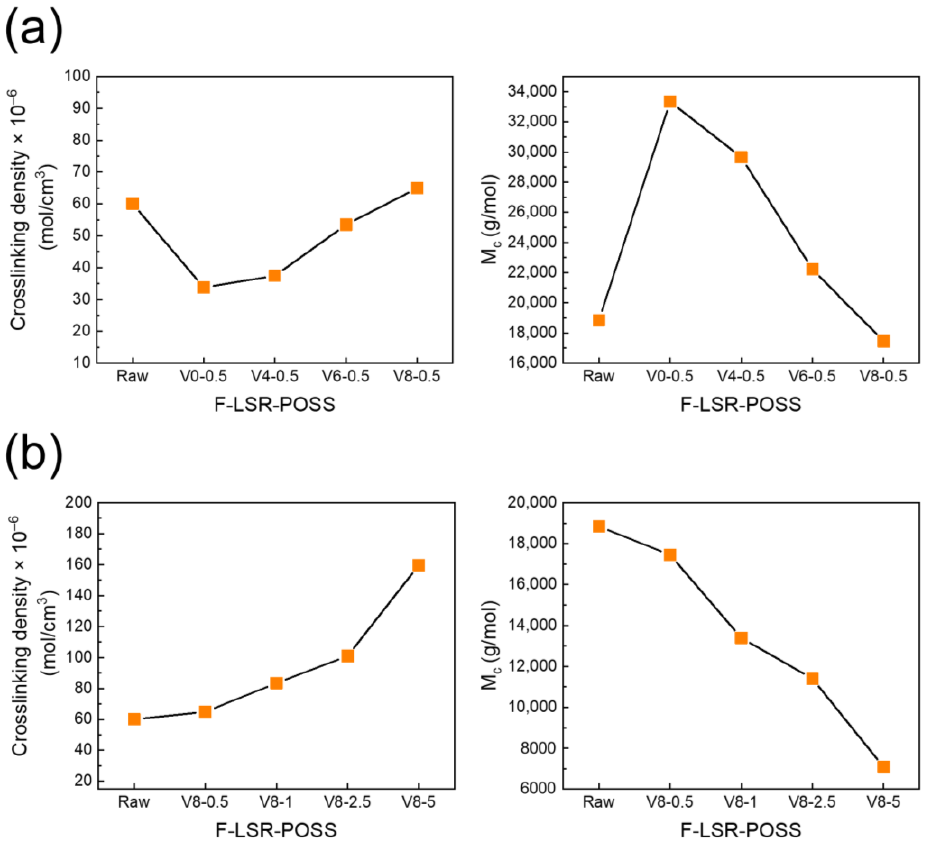
Figure 6. Crosslinking densities and M c of the F-LSR-POSSs: ( a ) with various types of POSSs and ( b ) with different POSS-V8 loadings.